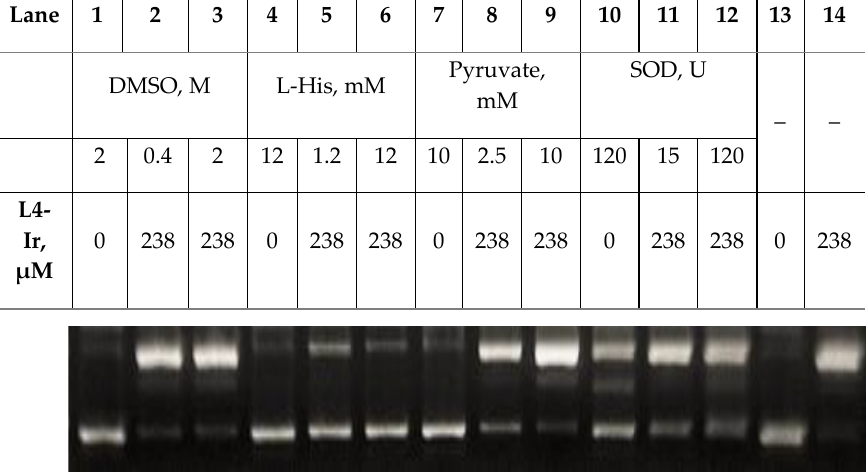
Figure 9. Cleavage electrophoresis of pUC18 (20 µM) incubated with L4-Ir or/and with DMSO (0.4 M and 2 M), L- histidine (1.2 mM and 12 mM), sodium pyruvate (2. 5 mM and 10 mM) or SOD (15 U and 120 U). Lane 13 is the control for pUC18 alone, and lane 14 is pUC18 with L4-Ir .